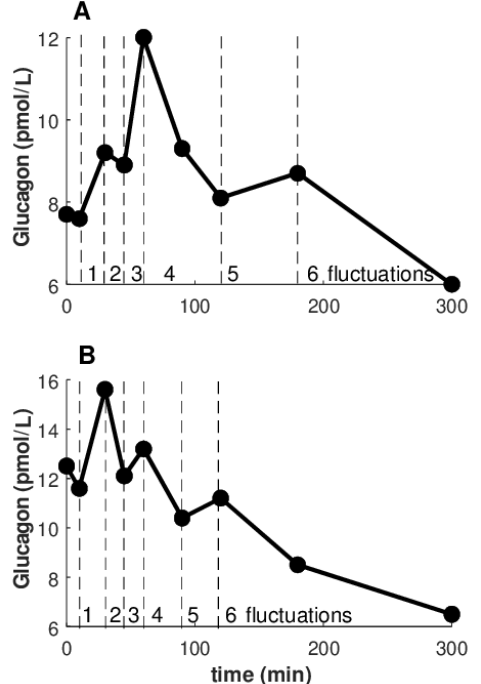
Figure 4. Calculation of fluctuations in glucagon curve: examples of cases with highest number of fluctuations observed (6 fluctuations). A : curve with positive Δ AUC GLUCA ; B : curve with negative Δ AUC GLUCA . Table 5. Number of fluctuations of glucagon curves in different metabolic tests.